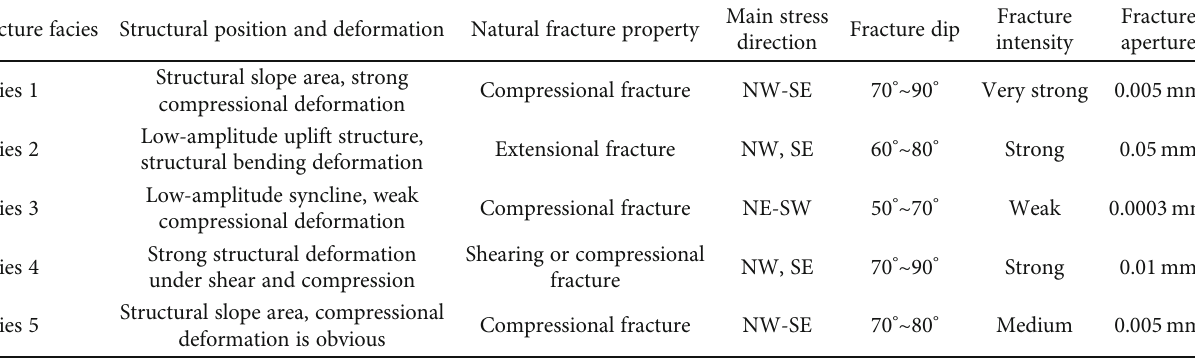
Table 1: Fracture facies division and fracture characteristic parameter distribution based on tectonic stress analysis in the study area. Fracture facies Structural position and